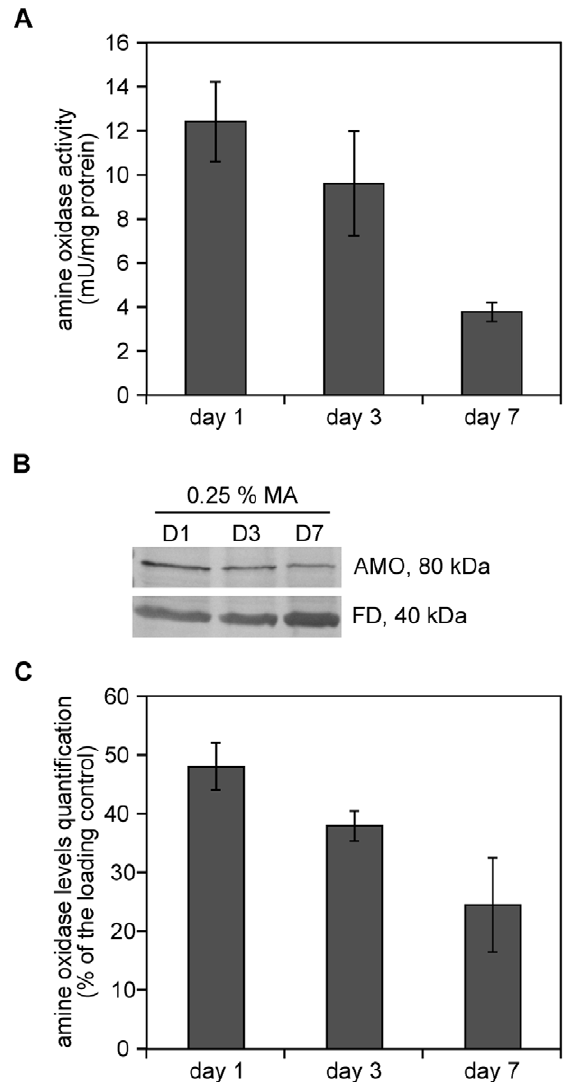
Figure 6. Specific AMO activities and AMO protein levels decrease during chronological aging. (A) Detection of AMO activities in wild-type cells in cultures grown on methanol in the presence of 0.25% methylamine during chronological aging. Bars indicate the standard error of mean of two independent experiments. (B) Western blot analysis of AMO protein levels in wild-type cells grown in the presence of 0.25% MA or on 0.25% ammonium sulphate (AS). Blots were decorated with specific antibodies against AMO. Formate dehydrogenase (FD) was used as loading control. (C) Quantification of the AMO levels using densitometric scanning of the blots. Two independent blots were quantified. The error bars indicate the standard error. The loading control was set to 100%.